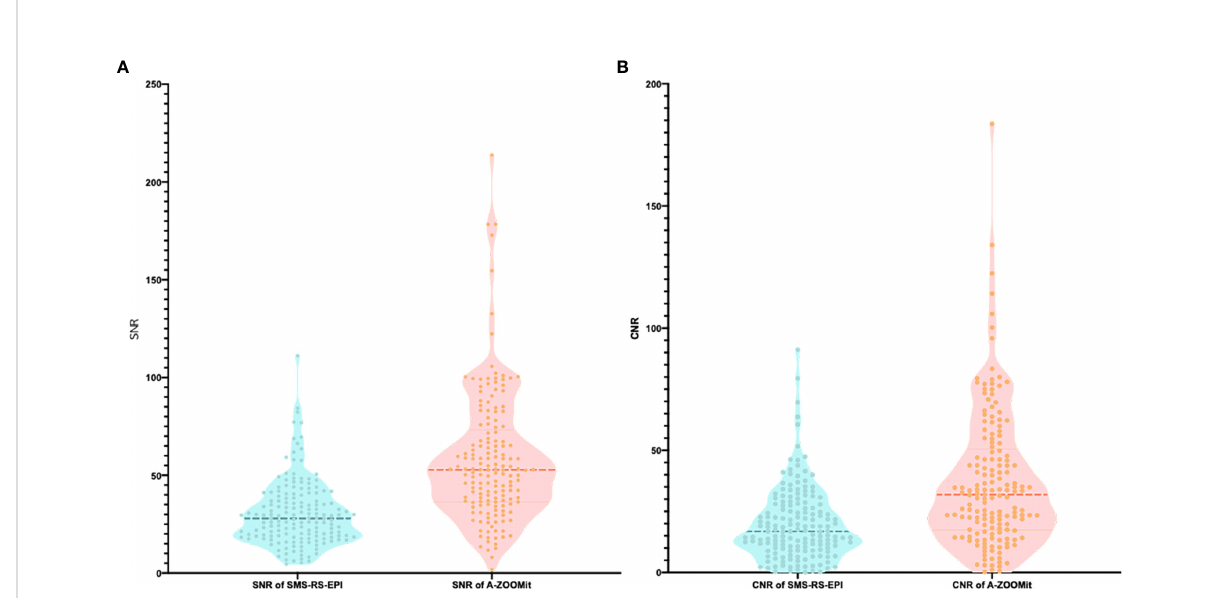
FIGURE 4 The SNR and CNR of b1,000 based on SMS-RS-EPI and A-ZOOMit. (A, B) There was a signi fi cant difference of SNR of b1000 based on SMS- RESOLVE and A-ZOOMit (p < 0.001) (A) ; There was a signi fi cant difference of SNR of b1000 based on SMS RESOLVE and A-ZOOMit (p < 0.001) (B)